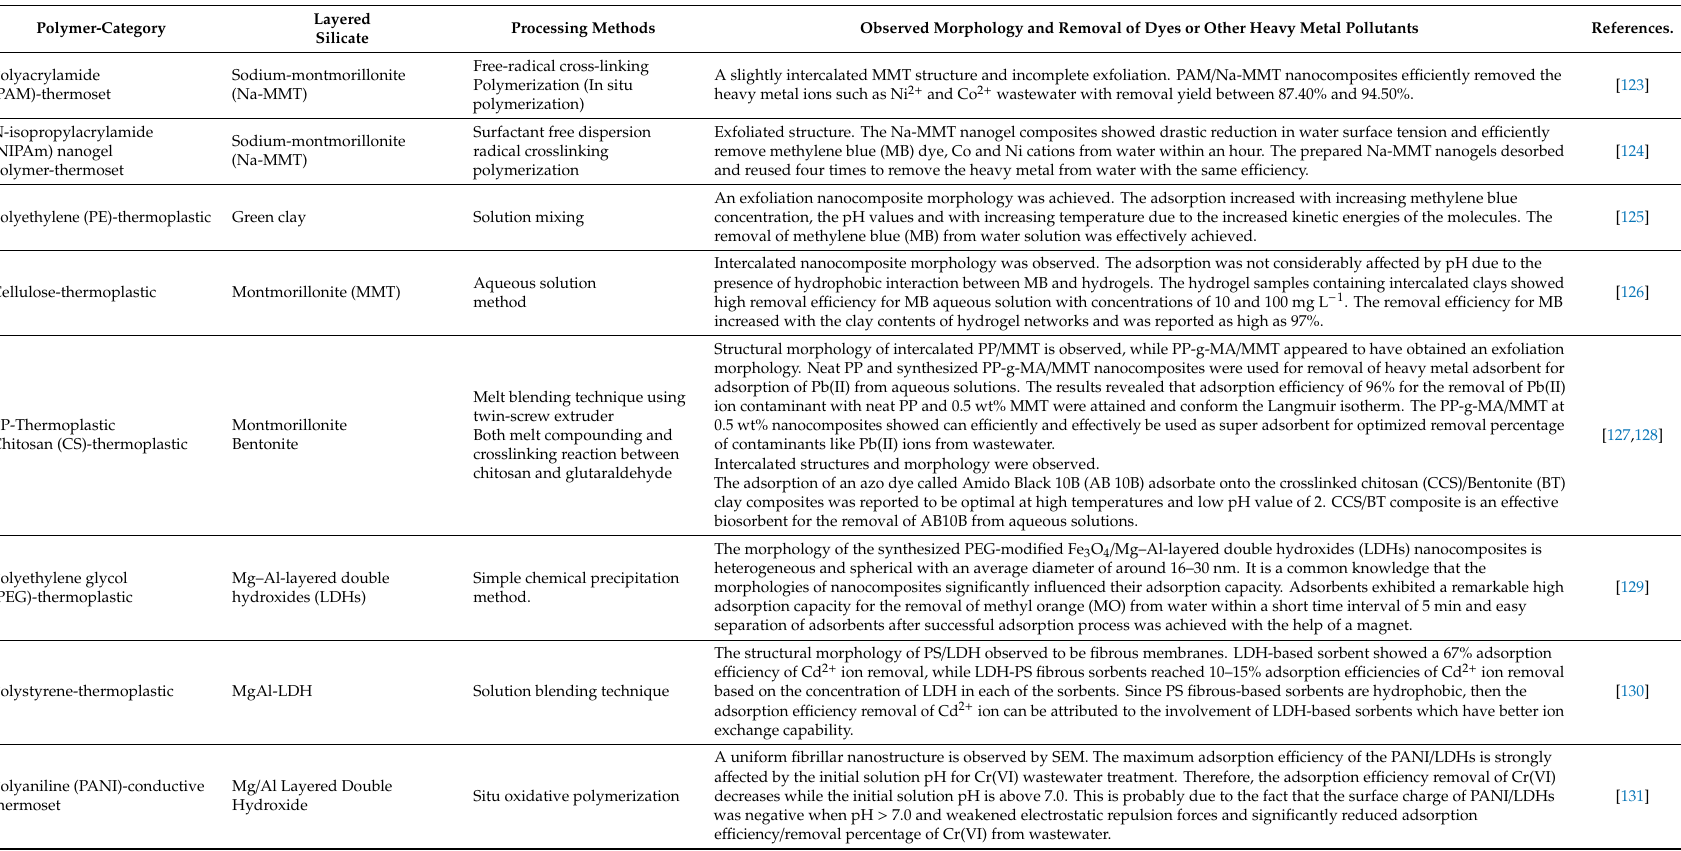
Table 3. Comparison of polymer-unmodified / modified layered double hydroxide and other nanoclays for water